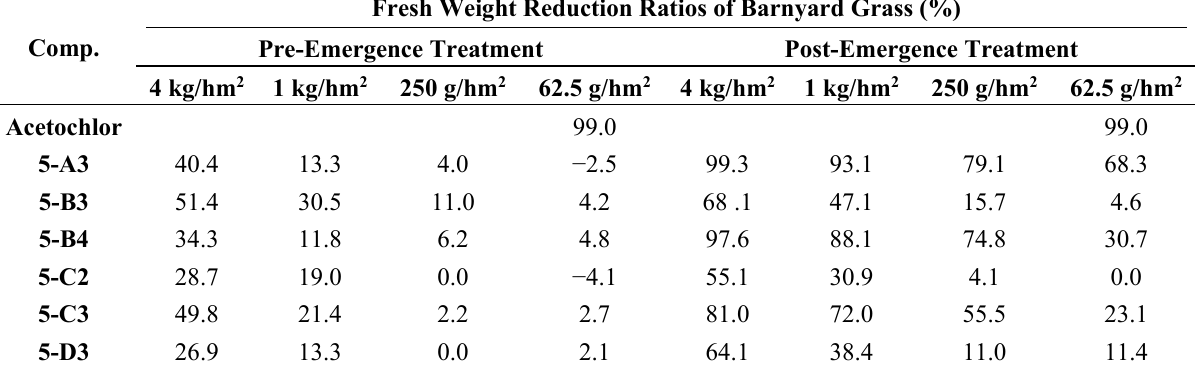
Table 2. The fresh weight reduction ratios of Barnyard grass at different concentrations of 5 .